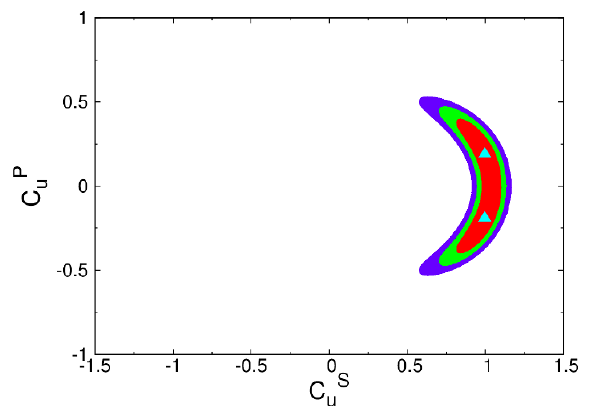
and C P . The color code u u